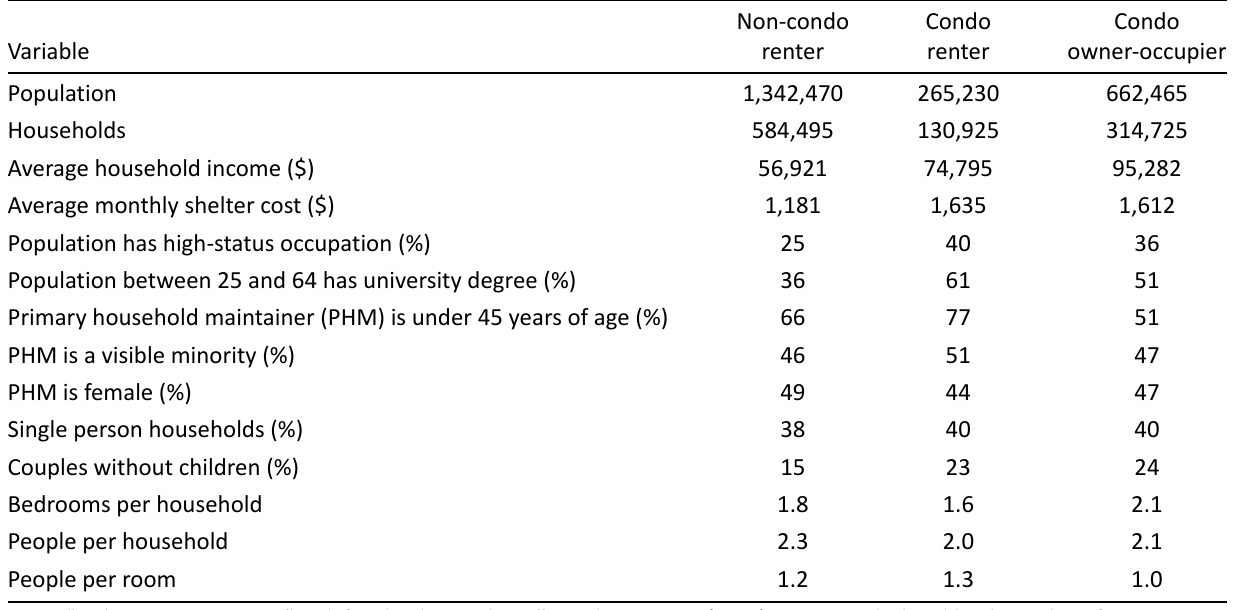
Table 1. Selected demographics by housing tenure for the Toronto CMA in